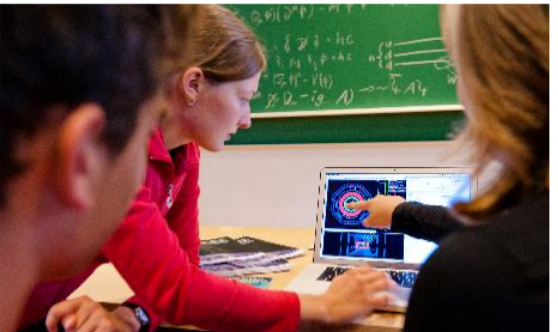
Figure 1 . Particle physics